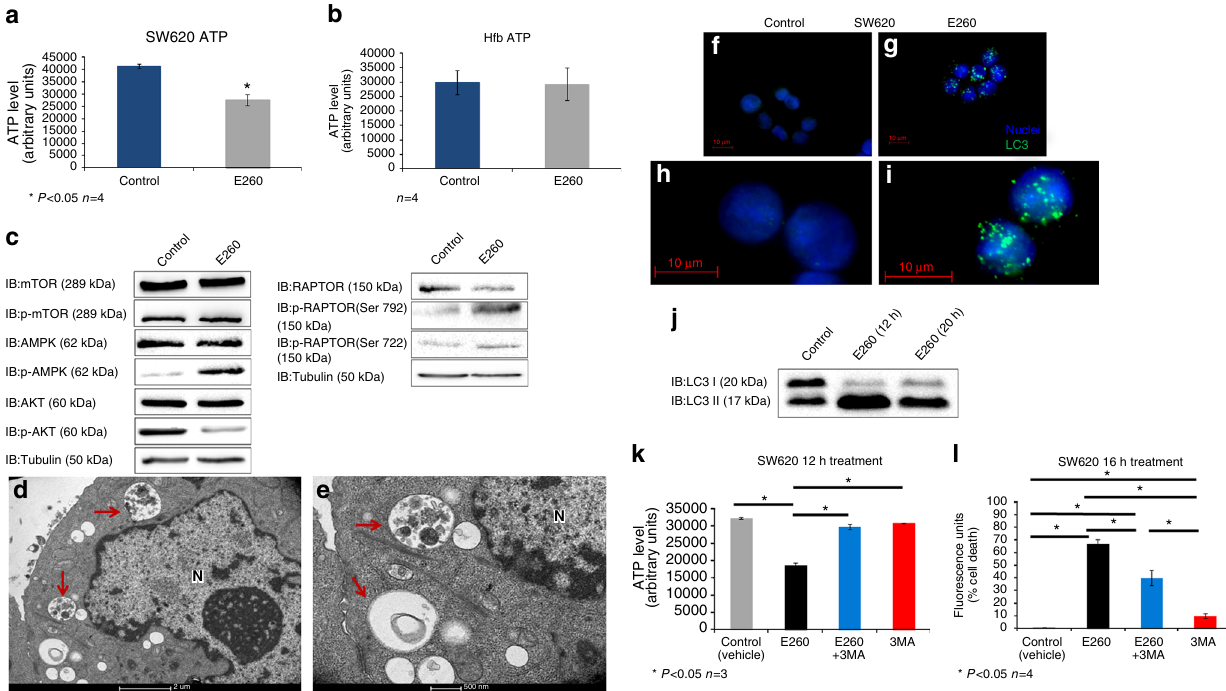
Fig. 4 Decreased ATP level and induction of autophagy in E260-treated SW620 cells. ATP levels in SW620 a and Hfb b cells treated with vehicle ( blue histogram ), or 2 µ M E260 ( gray histogram ) for 12 h; n = 4, ± SE. c Protein lysates from SW620 cells treated with control or 2 µ M E260 for 12 h were subjected to WB analysis of the total expression or phosphorylation level (p-X) of selected proteins from the AMPK – mTOR signaling pathway. d , e TEM analysis of SW620 cells treated with 2 µ M E260 for 12 h. Red arrows indicate autophagosomes. N nucleus. Bars represent 2 µ m in d and 500 nm in e . Immunostaining for LC3 ( green ) of SW620 cells treated with vehicles ( f , h ) or with 2 µ M E260 ( g , i ) for 12 h. Nuclei were visualized with Hoechst ( blue ). Bars represent 10 µ m. j Protein lysates from SW620 cells treated with control or 2 µ M E260 for 12 or 20 h were subjected to WB analysis using anti-LC3 antibody. k ATP levels in SW620 cells treated for 12 h with vehicle ( gray ), 2 µ M E260 ( black ), 2 µ M E260, and 5 mM 3-MA ( blue ), and 5 mM 3-MA alone ( red ); n = 3, ± SE. l Cell death levels in SW620 cells treated for 16 h with vehicle ( gray ), 2 µ M E260 ( black ), 2 µ M E260, and 5 mM 3-MA ( blue ), or 5 mM 3-MA alone ( red ); n = 4, ±